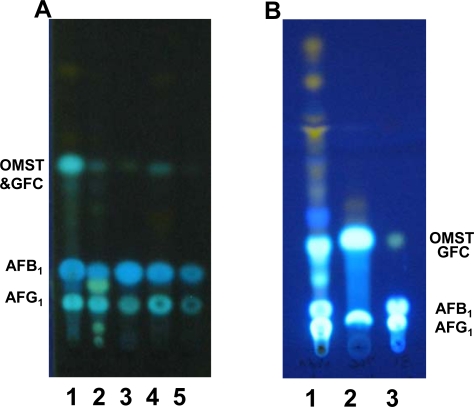
TLC of acetone extracts of A. parasiticus BN9ΔnadA, BN9ΔnorB, and BN9ΔnorA. (A) Lane 1, BN9ΔnadA clone 6; lane 2, BN9ΔnorB (clone B19); lane 3, OMST, AFB1 and AFG1 standards; lane 4, BN9ΔnorA extract; lane 5, BN9Δku70 transformed with a plasmid containing ptr1 (clone B4). (B) Lane 1, unpurified BN9ΔnadA extract; lane 2, TLC of purified GFC from BN9ΔnadA clone 6; lane 3, standards as above.